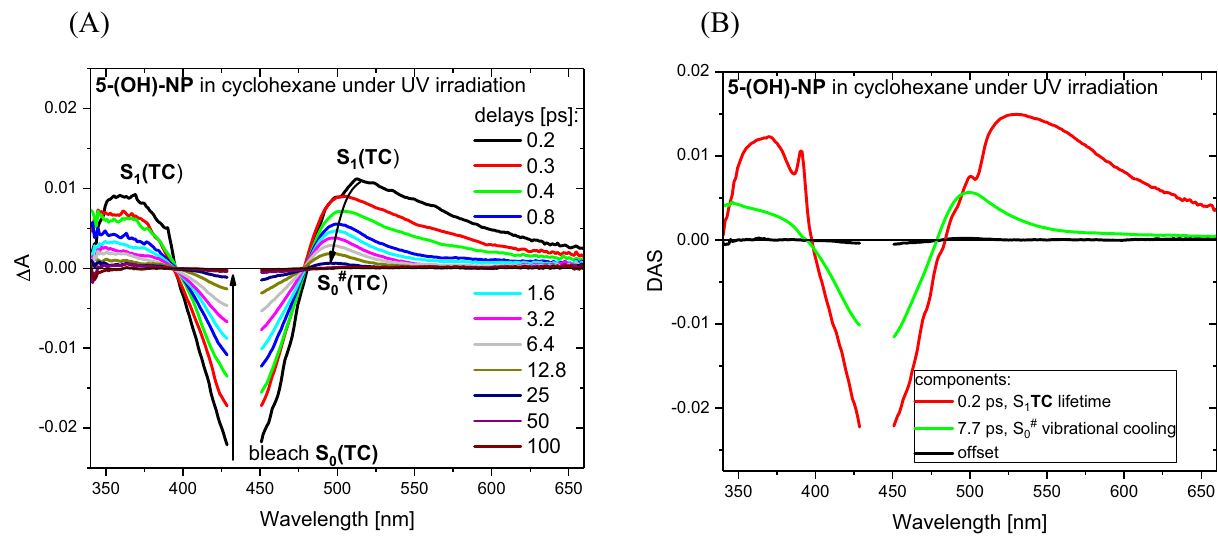
Figure 5. ( A ) UV–Vis transient absorption spectra recorded for TC solution in cyclohexane upon the laser pulse excitation at λ = 444 nm. PSS with a constant TC population was achieved by a continuous irradiation of 5-(OH)-NP cyclohexane solution with LED at λ = 340 nm. ( B ) Decay associated spectra obtained with global analysis using bi-exponential